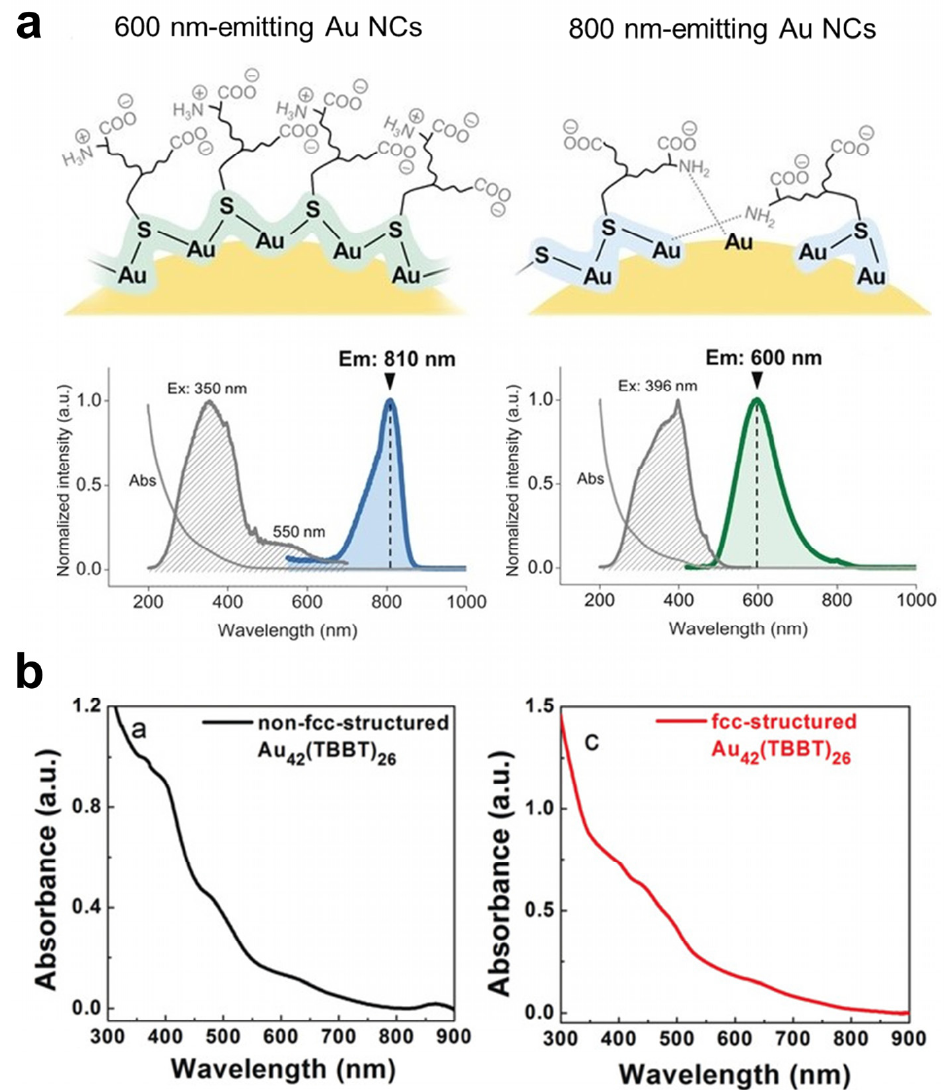
Figure 5. Surface motif-related photoemission of MNCs ( a ) The upper section is the schematic diagram of the surface environment of Au NCs corresponding to 600 nm and 810 nm emissions, respectively. The bottom section is the absorption, excitation, and emission spectra of Au NCs. Copyright (2016) Wiley-VCH. ( b ) Schematic structure and corresponding photoluminescence spectra of Au42(TBBT)26 with the same composition but different metal core packing modes.